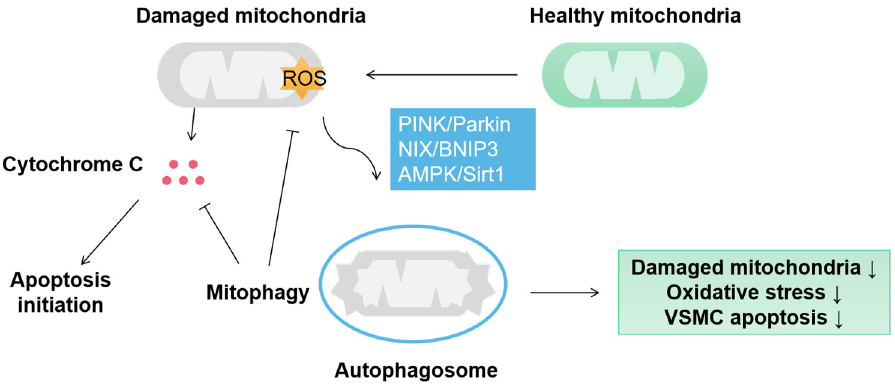
Figure 3. Mitophagy protects VSMC by eliminating damaged mitochondria. In VSMC, mitophagy is mainly aroused by PINK/Parkin, NIX/BNIP3 and AMPK/Sirt1 pathways and induces sequestration of damaged mitochondria by autophagosomes. Mitophagy protects the VSMC from the damage of oxidative stress and cytochrome C-activated apoptosis.